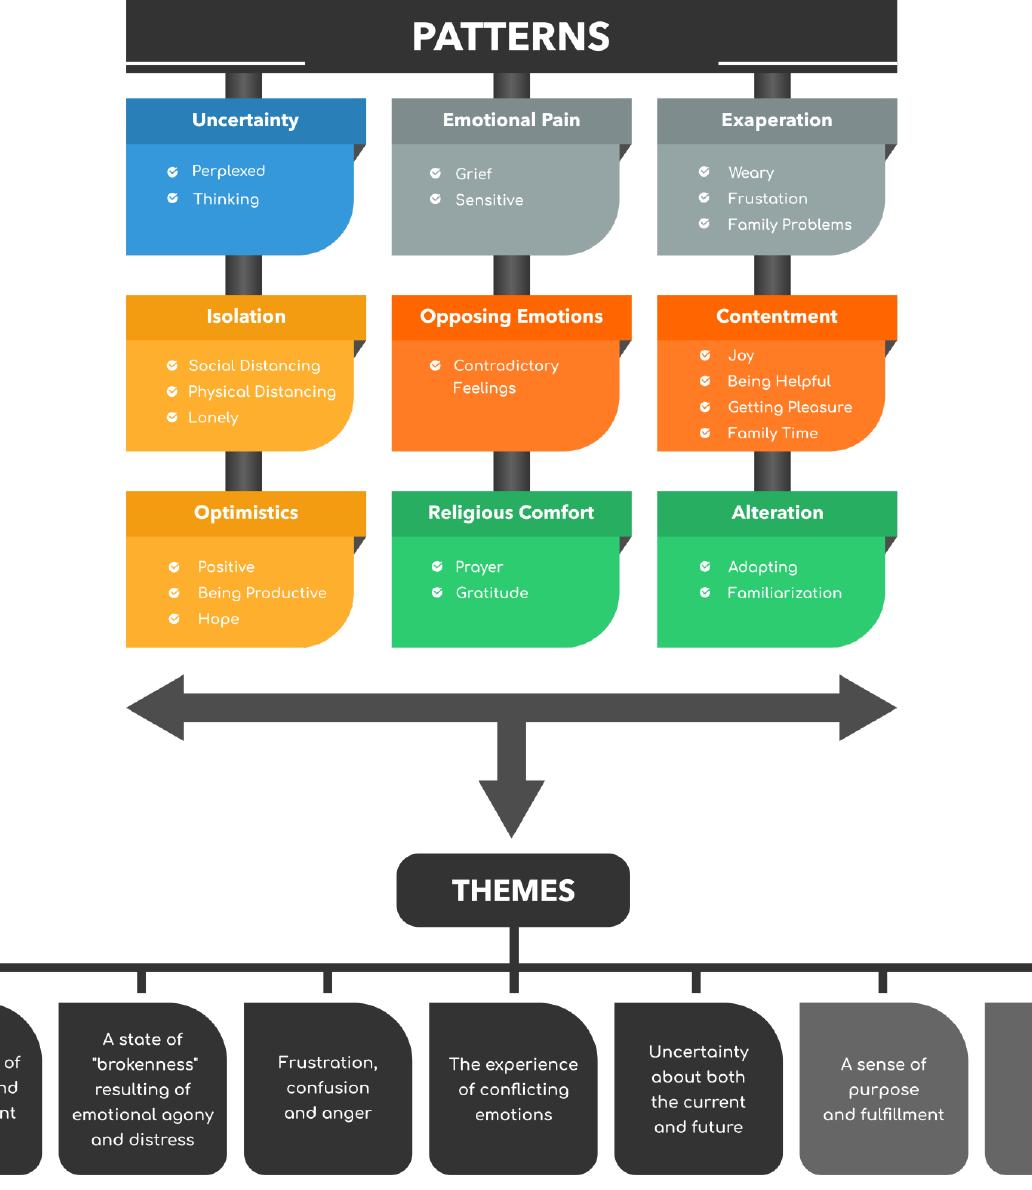
Figure 5. Patterns and themes.